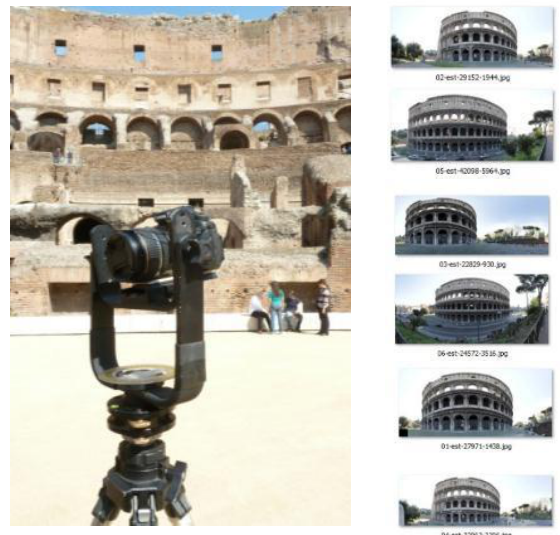
Figure 3. Bas-relief, Portal of Santa Maria della Piazza, Ancona. 27 input photos (resolution of 2592x1728px) and 3D